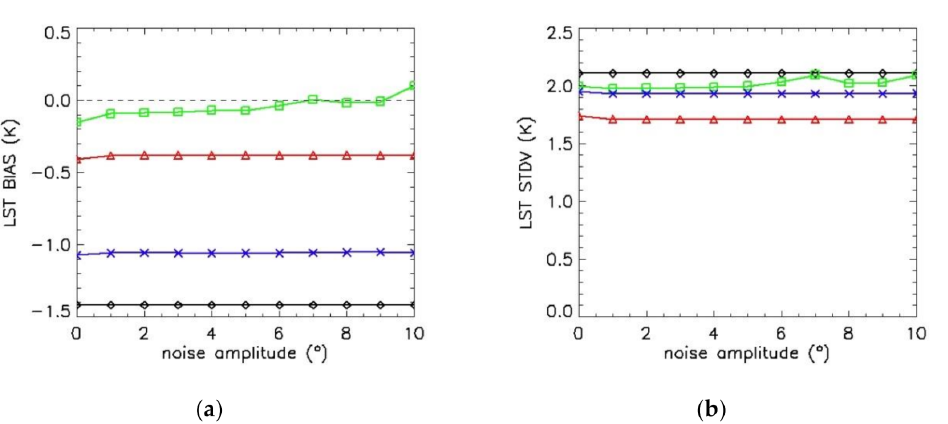
Figure 9. Overall bias ( a ) and standard deviation ( b ) values as a function of the noise amplitude introduced in the drifted solar zenith angle (SZA) time series for the LST drifted time series (black diamonds) and the corrected time series C0, C1, and C2 (red triangles, green squares, and blue crosses,